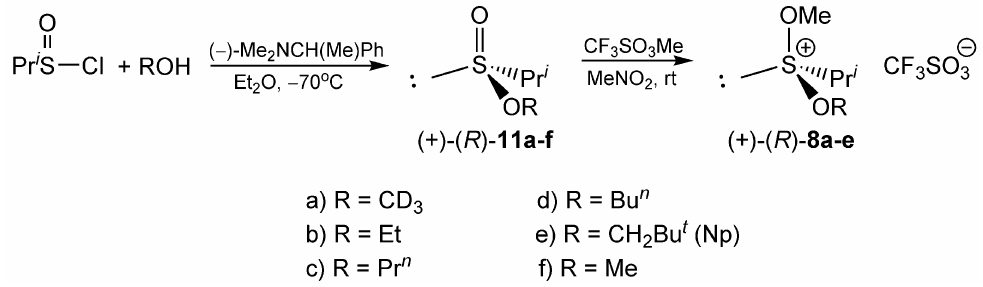
Figure 2. Structures of dialkoxysulfonium and phosphonium salts used in the present and in earlier studies on nucleophilic substitution at heteroatoms (anions omitted).